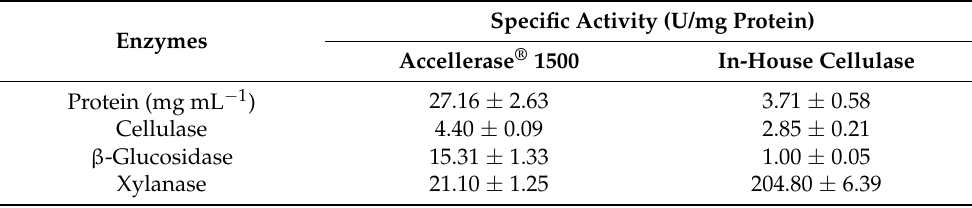
Table 1. Enzyme activities used for Jerusalem artichoke stalk